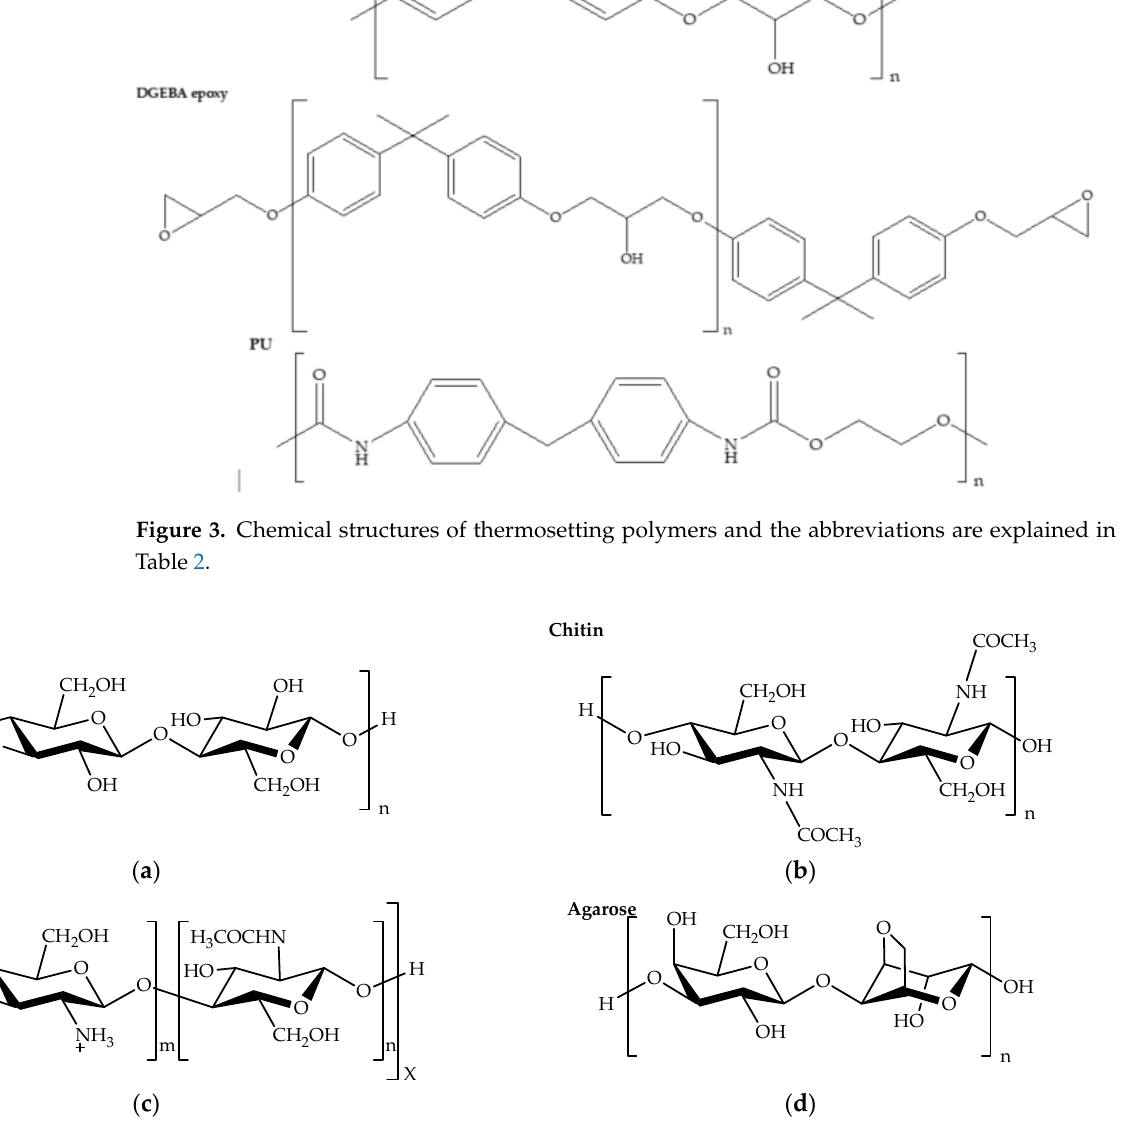
Table 5. Examples of quaternary ammonium surfactants (QASs) applied for compatibilization of polymer blends and polymer composites. QASs